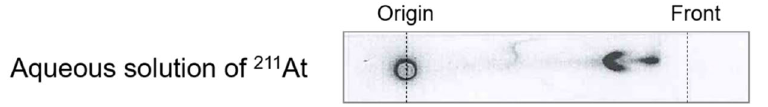
Figure 1. Representative radio-TLC profile of the aqueous solution of 211